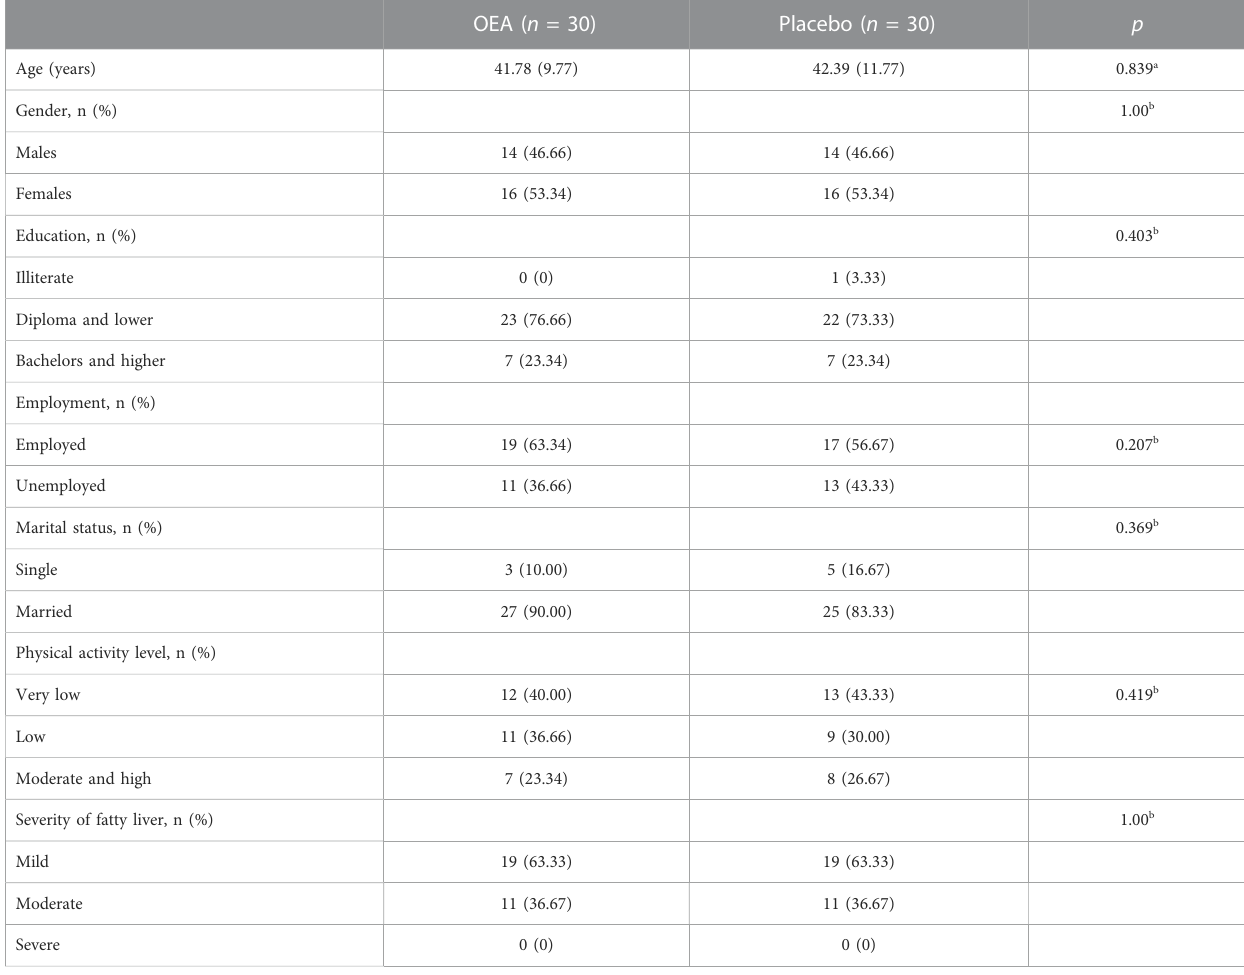
TABLE 1 Baseline characteristics of the study